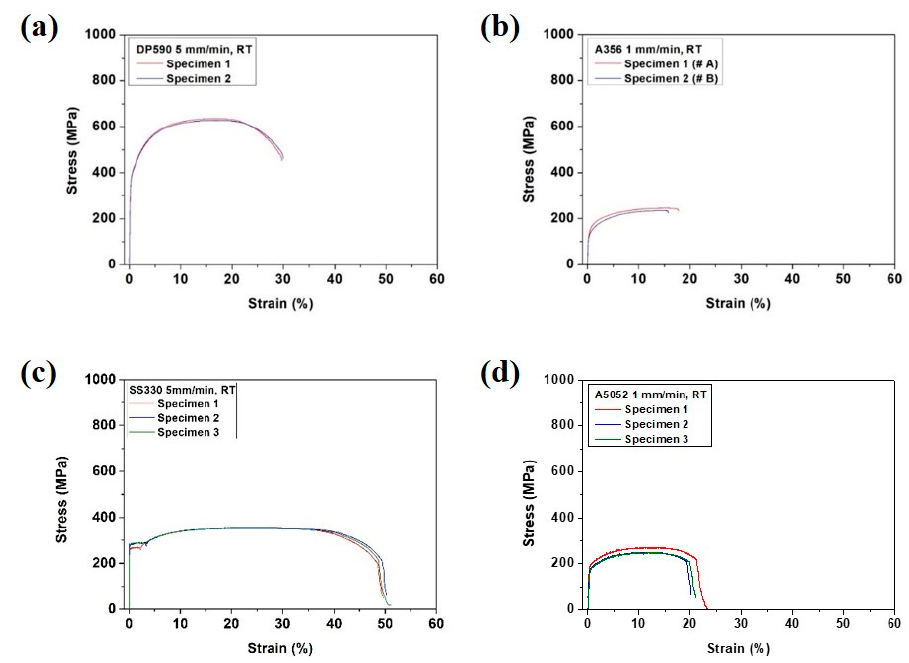
Figure 3. Structure of the bending test.